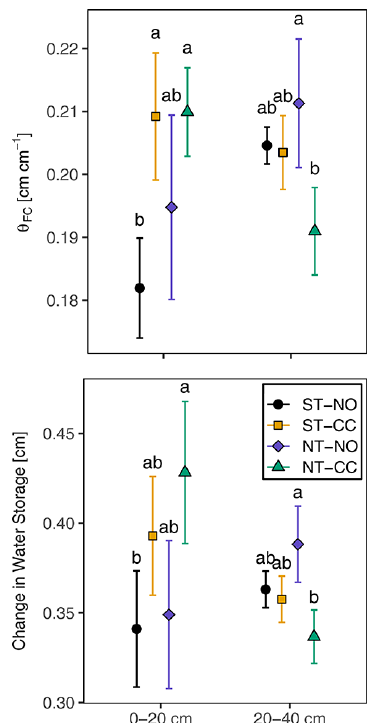
Figure 9. Dynamic field capacity ( θ FC ) and water storage change on day 3 after irrigation. Bars indicate standard errors. Different letters indicate differences at p < 0 .